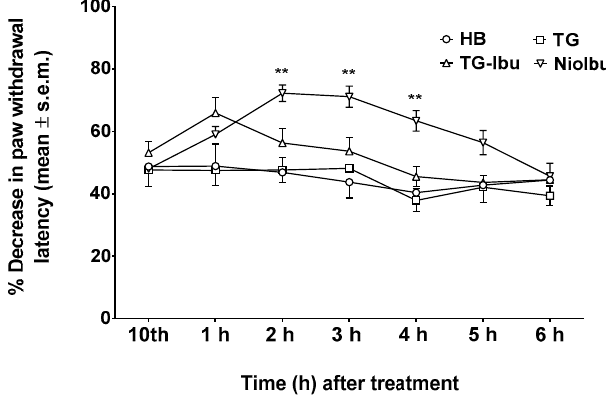
Figure 7. Effects of Hepes buffer (HB), the unstructured surfactant formulation (TG), the unstructured surfactant formulation with the same Ibuprofen (IBU) concentration (TG-Ibu), and TW20-Gly loaded with IBU (NioIbu) on hyperalgesia induced by a chronic constriction injury of the right sciatic nerve. * is for P < 0.05 and ** is for P < 0.01 versus TG. N = 8.